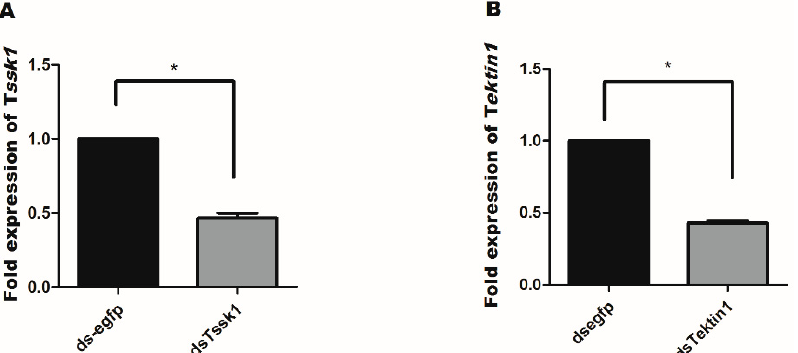
Figure 5 . Gene silencing of Tssk1 and Tektin1 in testis of males of B. dorsalis caused by oral feeding of dsRNA at the concentration of 1000ng/uL. The control was treated with ds-egfp. (A) Fold change in Tssk1 gene transcription. (B) Fold change in Tektin1 gene transcription. One-way ANOVA was used to analyze the results. * shows significant difference at p < 0.05.